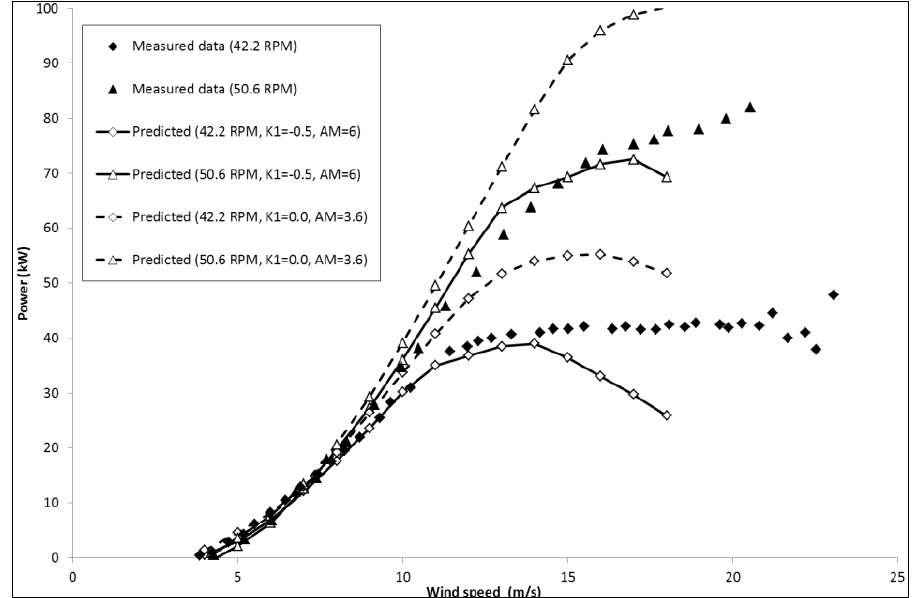
Figure 6. Sandia 17m Φ-rotor power vs. wind speed at 42.2 and 50.6 rpm.